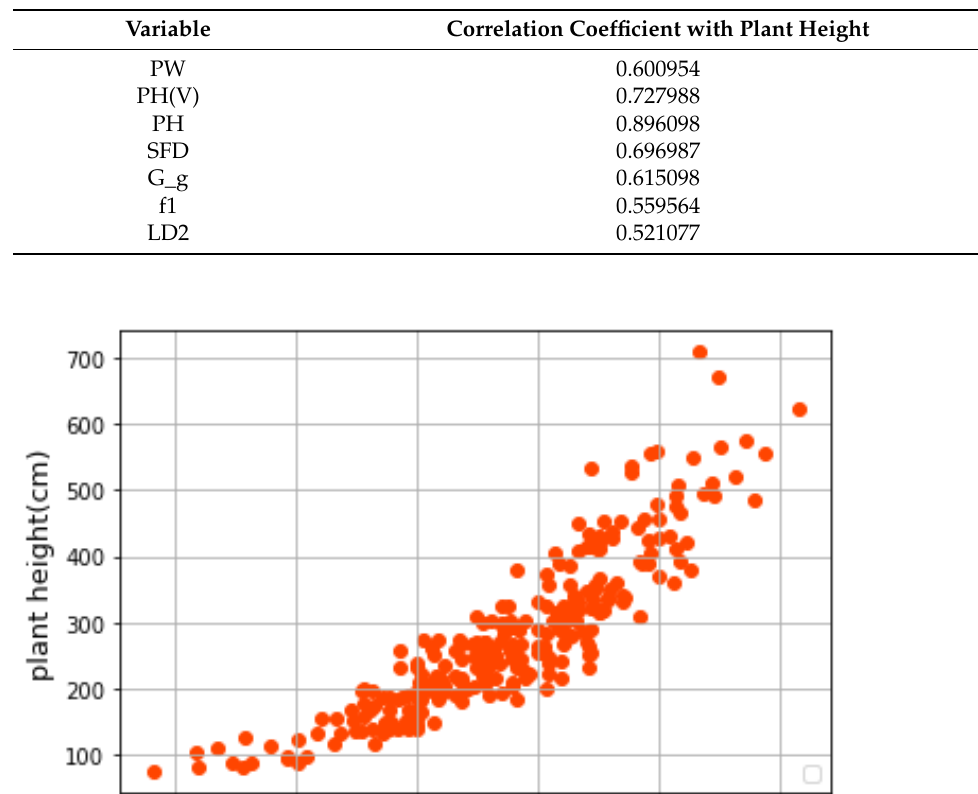
Table 2. Correlation coefficient between characterization and fresh weight of rice.